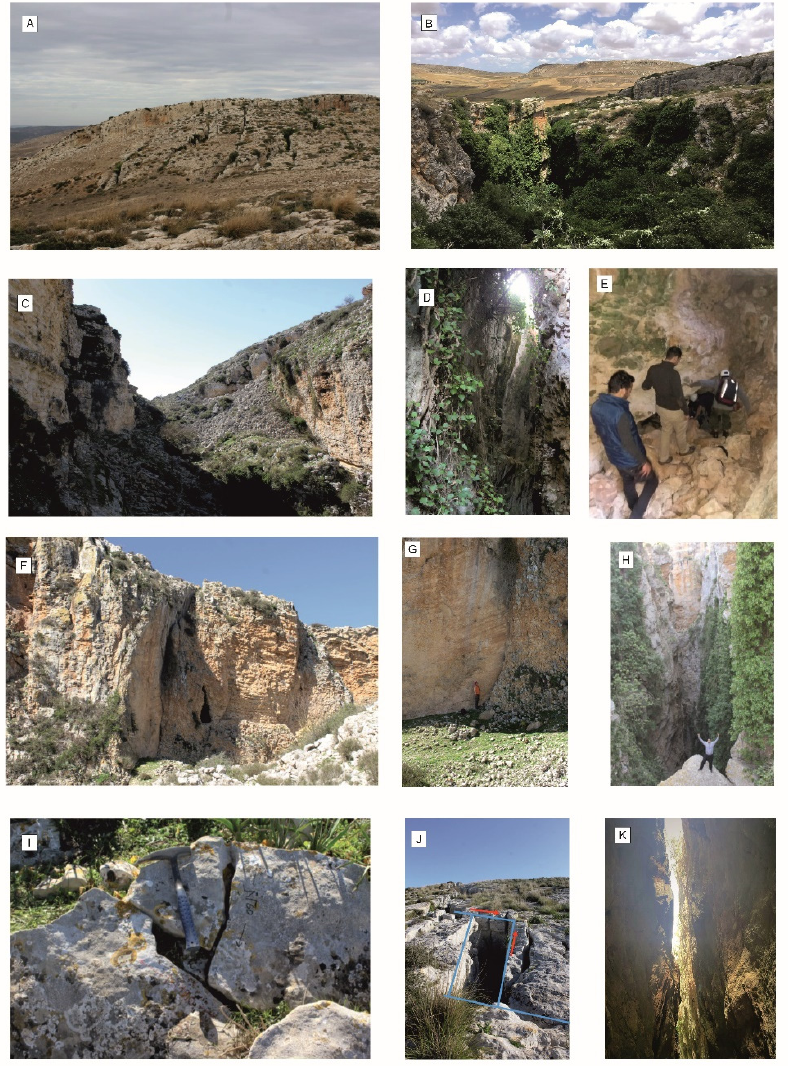
Figure 9. Photographs of various sectors of the Chgega Mountain. ( A ) Open joints in the southwest- ern sector. ( B ) Deep trench in the northeastern sector. ( C ) Interior of the gravity-induced graben where tilted blocks and rockfall deposits are observed. ( D ) View of a deep open fracture from its bottom. ( E ) Entrance to crevice-type cavities. ( F ) Rock walls forming the boundary of the graben. The center cliff is formed by fault breccia. ( G ) Slickenside cropping out in the graben. ( H ) Deep open fracture in the eastern sector. ( I , J ) Main discontinuity sets observed in the Chgega Mountain. ( K ) Narrow passage through an open